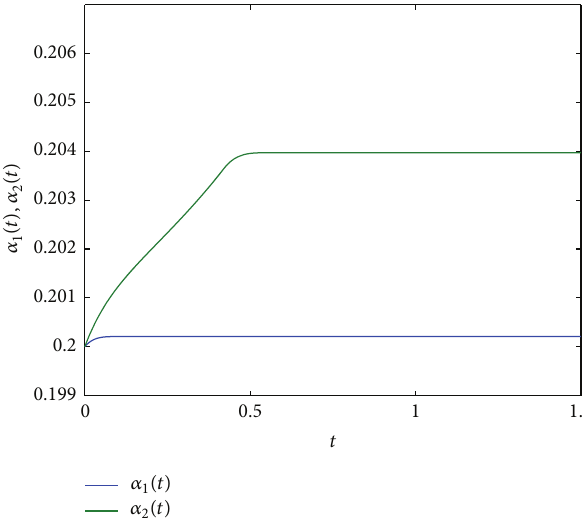
Figure3:Phaseplanebehaviorofthemastersystem(1)andthesalve system (40) with 𝑢 𝑖 = 0 .